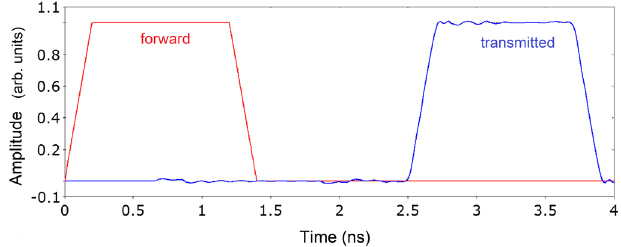
FIG. 4. The forward and transmitted pulses at the feeding port.